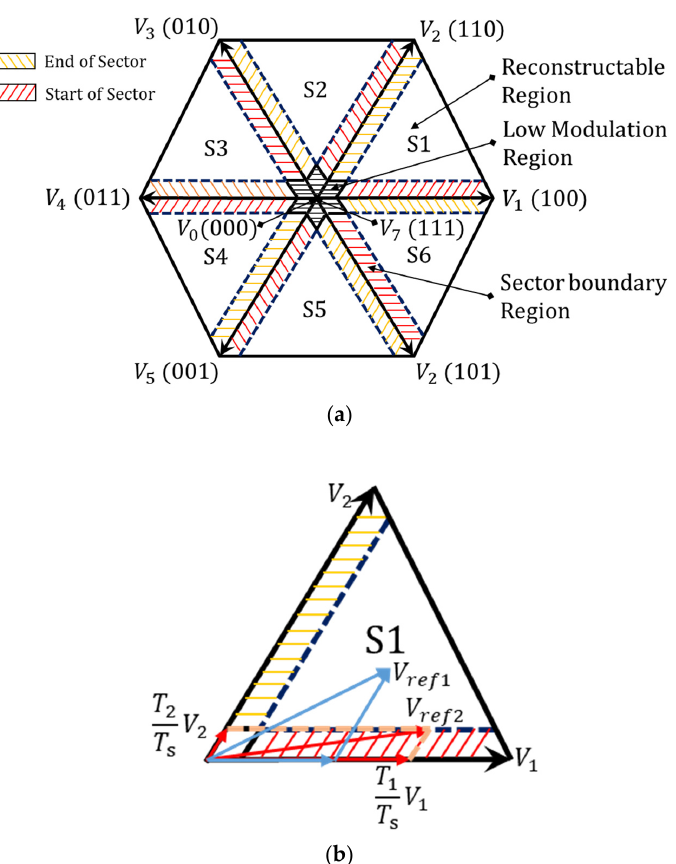
Figure 3. Different regions and vector composing: ( a ) voltage space vectors diagram in different regions. ( b ) reference voltage vector in a sector boundary region, V ref 1 is reconstructable vector in reconstructable region, V ref 2 is reconstructable vector in sector boundary region.